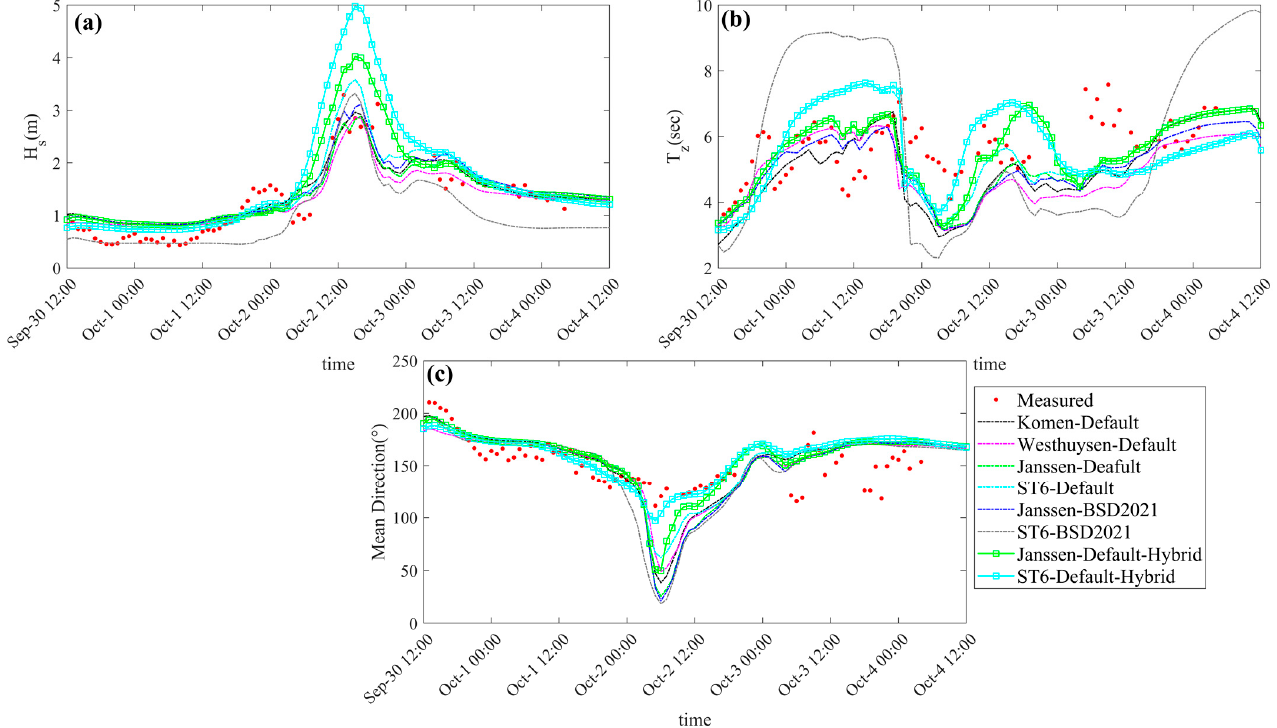
Figure 10. Simulated ( a ) H s (m), ( b ) T z (s), and ( c ) mean direction ( ◦ ) compared with Chabahar buoy measured data.